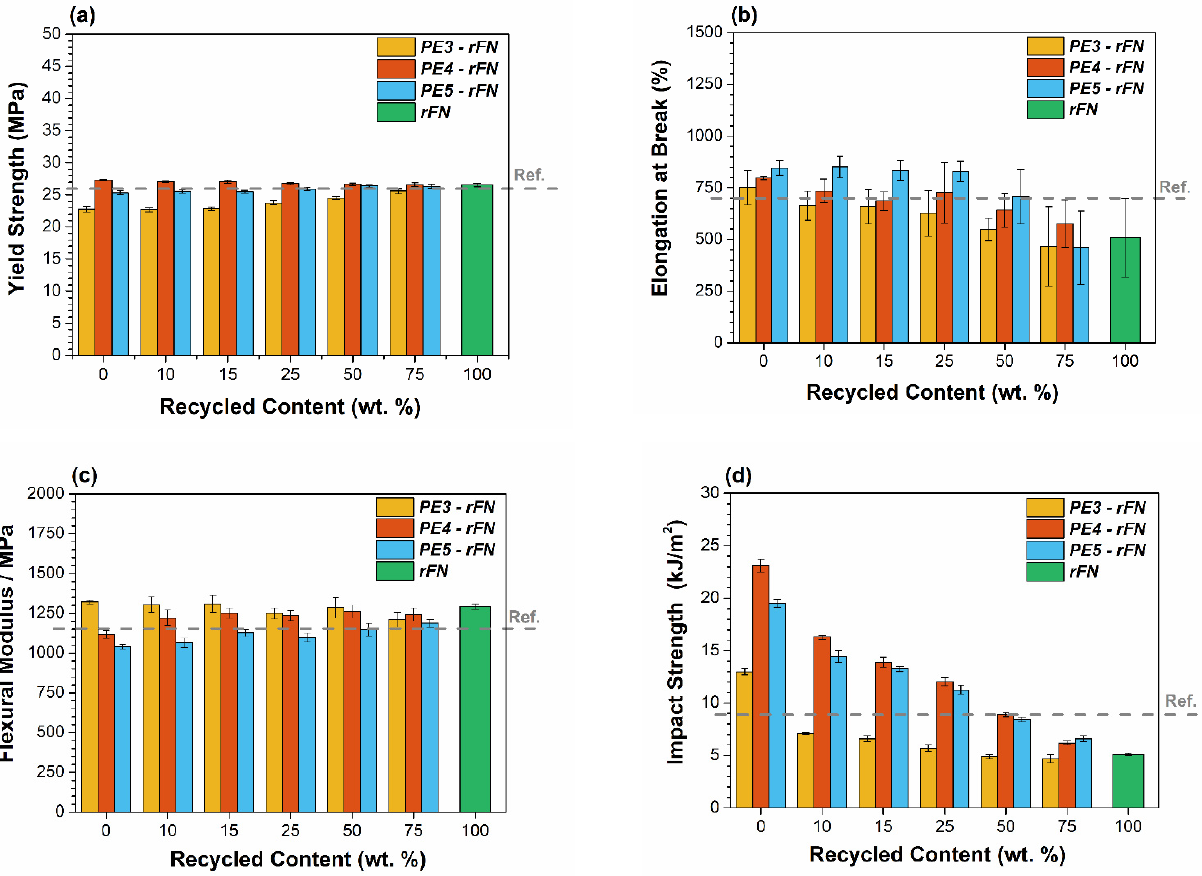
Figure 6. ( a ) Yield strength, ( b ) Elongation at break, ( c ) Flexural modulus and ( d ) Impact strength resistance results for PE3—PE4 and PE5—rFN blend systems.